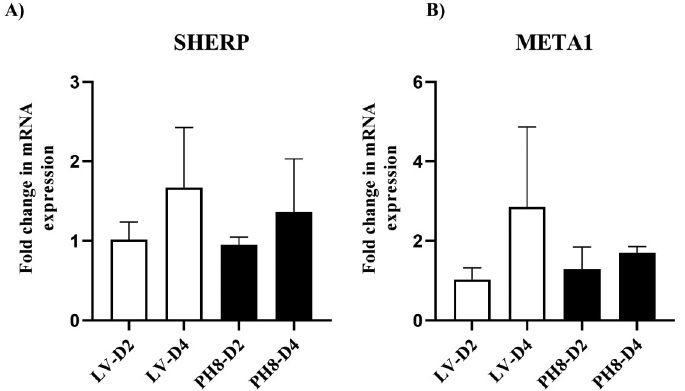
Fig 10. Relative expression of SHERP and META1 in LV79 and PH8 cultures. Synchronized cultures from day 2 (D2) and day 4 (D4) were collected for comparative analysis of transcripts of SHERP, META1 and GAPDH. Data obtained by RealTime RT-PCR of three independent cultures for each strain, using GAPDH as the reference gene and mean values of LV79 D2 for normalization. Statistical analysis by ANOVA with Tukey posttest.